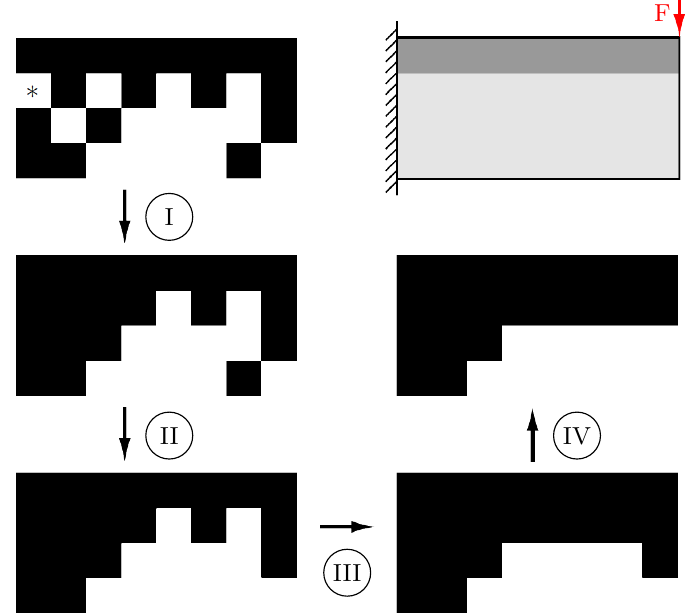
Figure 4. Two-dimensional feasibility filtering. Top right : Exemplary two-dimensional design problem with shaded fixed elements. Top left : Material density as taken directly from the generated gene. I: Holes are filled. The asterisk marks a boundary condition exception. II: Unconnected solid elements are removed. III: Elements surrounded by three solid elements are filled. IV: Solid elements that are only connected on one side are